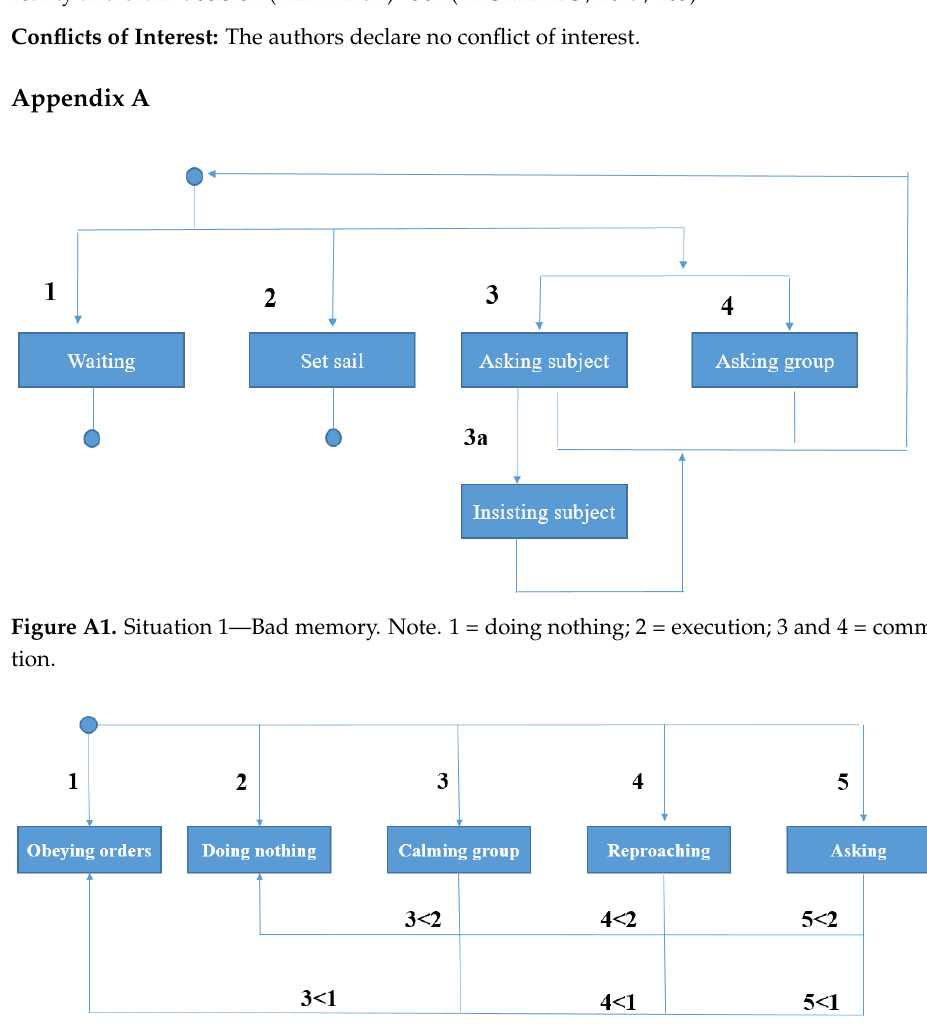
Figure A4. Situation 4—The letter. Note . 1= doing nothing; 2 = execution; 3 and 4 = communication. Figure A5. Situation 5—Symptoms. Note. Part I: 1 = doing nothing; 2 = giving orders; 3 = execution. Part II: Conflict: 1.A = Change in attitude: communication, 2.A = no change in attitude: giving orders, 3.A = change in attitude: communication; 1.B = no change in attitude: do nothing, 2.B = change in attitude: communication, 3.B = change in attitude: communication; 1.C = change in attitude: com- munication; 2.C = change in attitude: communication, 3.C = no change in attitude: execution and communication.